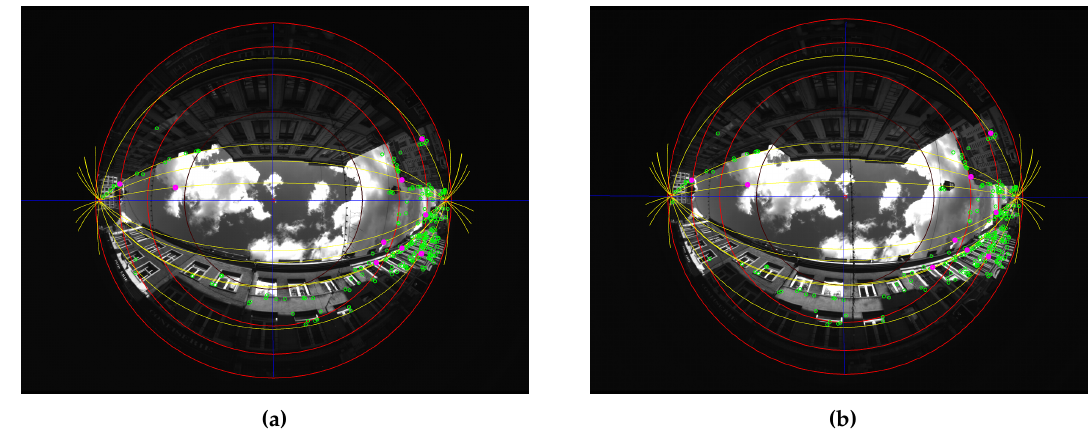
Figure 8. Illustration of the calibration, scene Cap4/1560 of acquisitions done in Lille. ( a ) Rear view; ( b ) Front